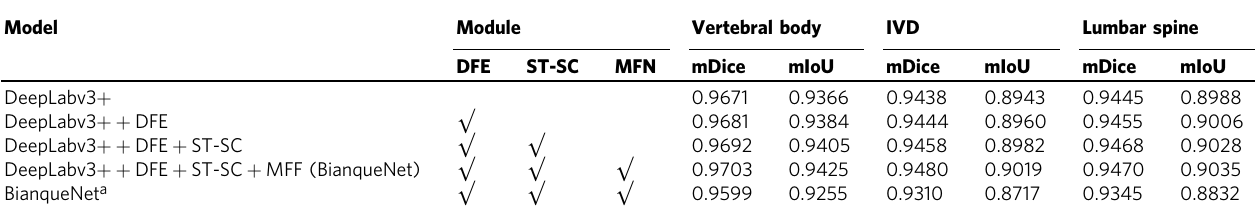
Table 1 Segmentation performance of BianqueNet compared with those without other modules (DFE, ST-SC, and MFF) in test sets.